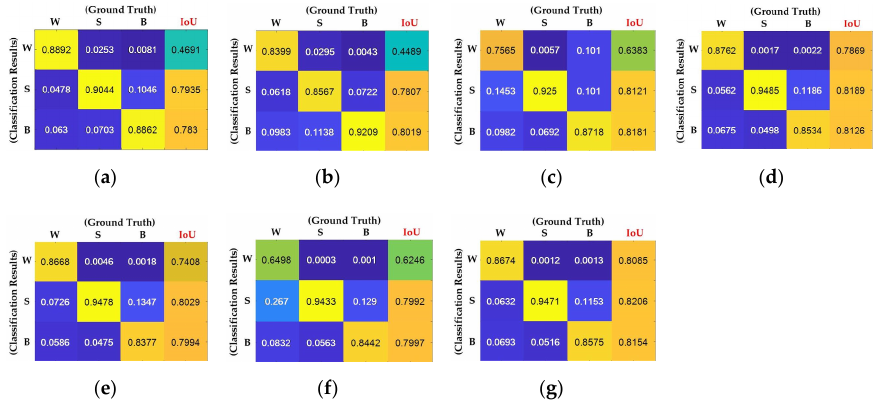
Figure 17. The classification accuracy and IoU of different methods for the second experiment. ( a ) RefineNet. RefineNet. ( b ) DeepLabV3. ( c ) MLSAN. ( d ) GLGCM-MLSAN. ( e ) Gabor-MLSAN. ( f ) MSOGDF-MLSAN. ( b )DeepLabV3. ( c )MLSAN.( d )GLGCM-MLSAN.( e )Gabor-MLSAN.( f )MSOGDF-MLSAN.( g )MSF-MLSAN. ( g ) MSF-MLSAN. (W, S and B denote Water, Shadow and Background, respectively.). (W, S and B denote Water, Shadow and Background,